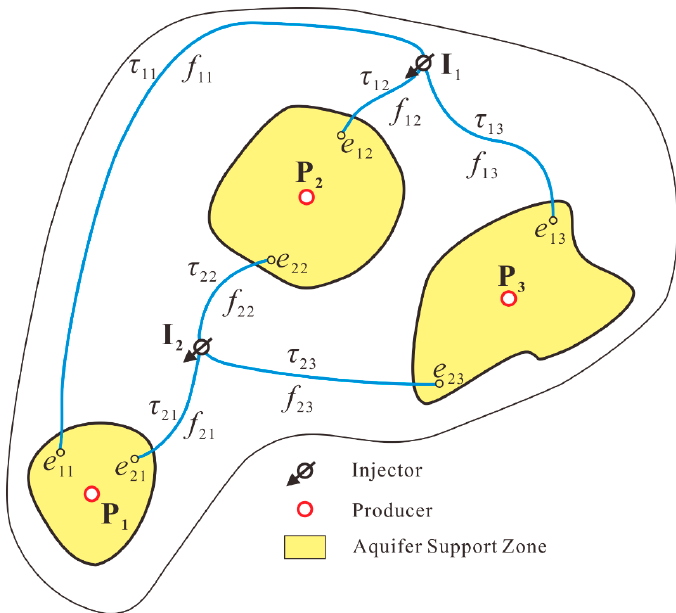
Figure 1. Schematic diagram of an injector–producer-pair-based control volume that is widely distributed in karst waterflood carbonate reservoirs.